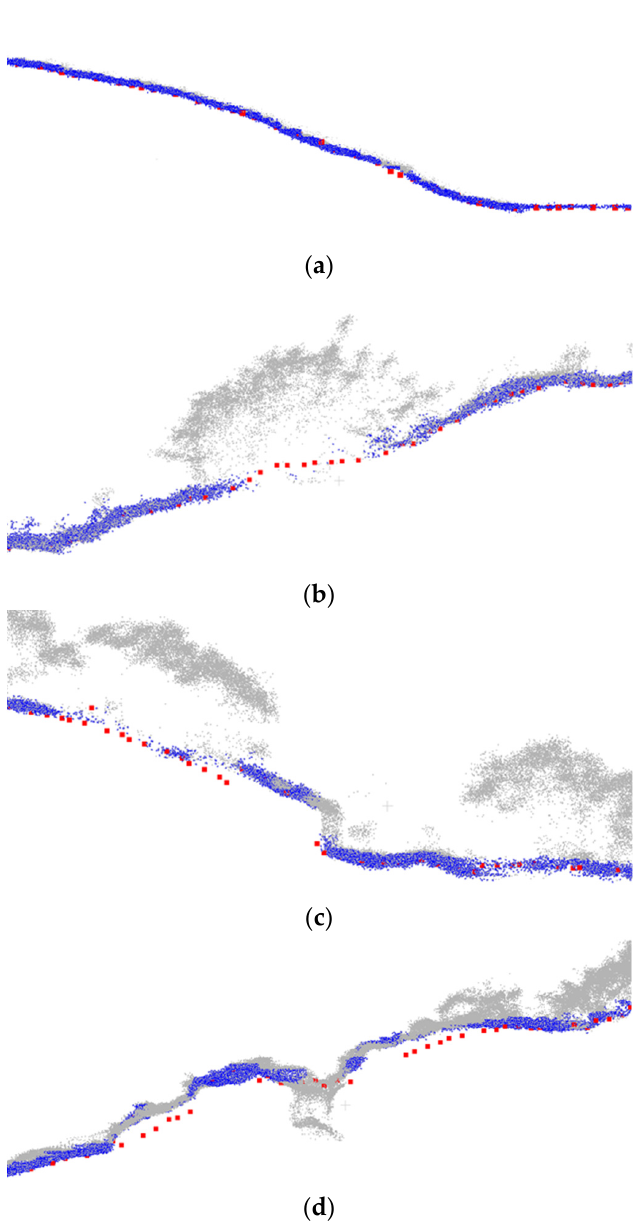
Figure 14. Enhanced DTM (in red), bare-earth points (in blue), and remaining LiDAR points (in gray) using the proposed mitigation strategies for the challenging cases in Figure 10: ( a ) presence of a noise/outlier points; ( b ) sparse points on the ground caused by dense vegetation; ( c ) rugged terrain with sudden elevation change; and ( d ) presence of an underground structure.